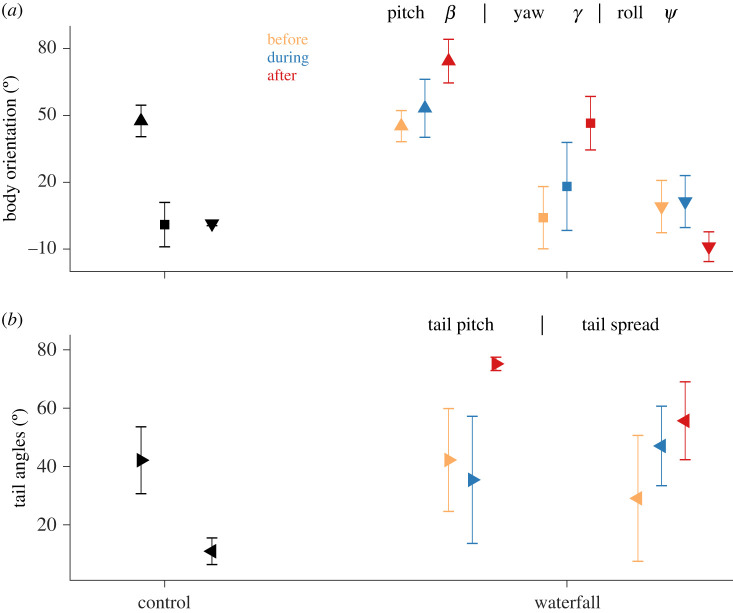
(a) Body and (b) tail angles for the same four hummingbirds flying in still air (black), and before (orange), during (blue), and after (red) crossing the waterfall. Symbols in (a) denote pitch (upward triangle), roll (square) and yaw (downward triangle); those in (b) indicate tail pitch (triangle pointing right) and tail spread angle (triangle pointing left). Data points represent means ± one standard deviation.